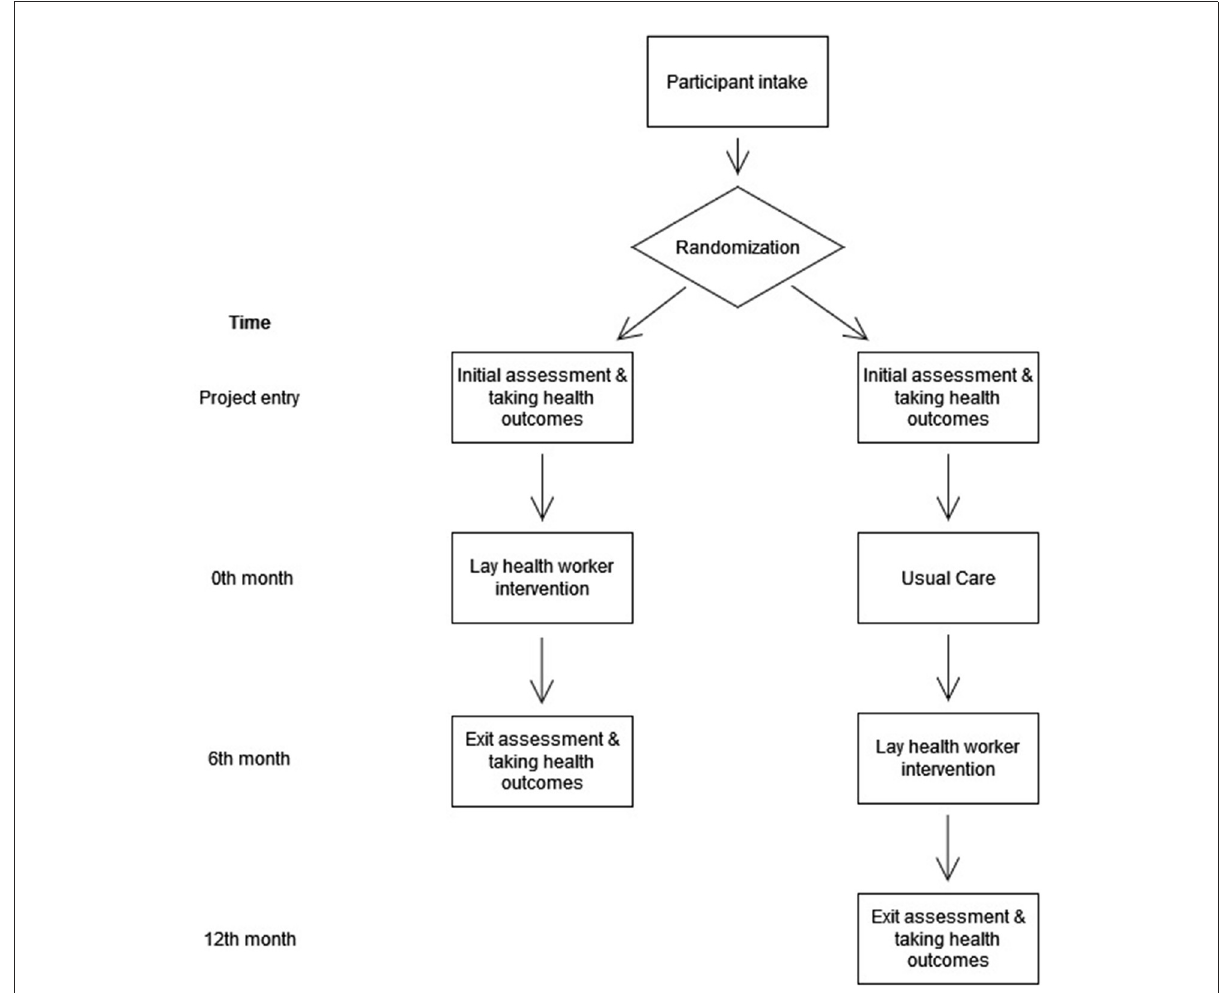
FIGURE1 CONSORT workflow of this